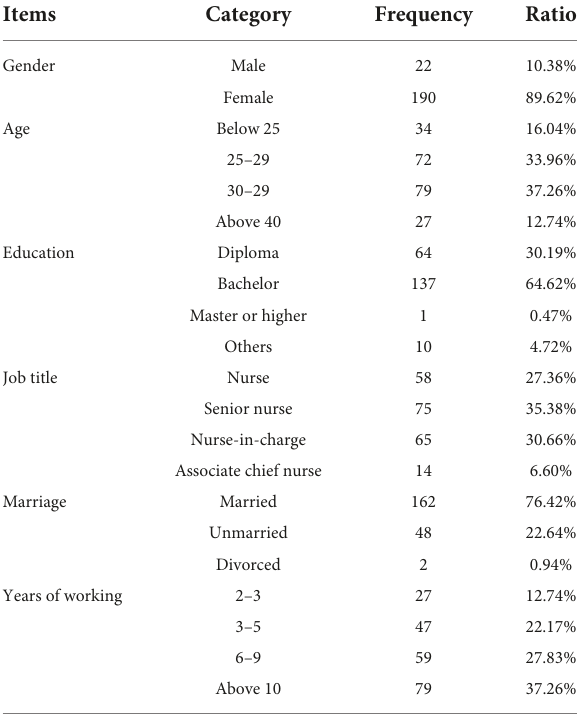
TABLE 1 Demographic information of respondents. TABLE 2 Measurement items of job